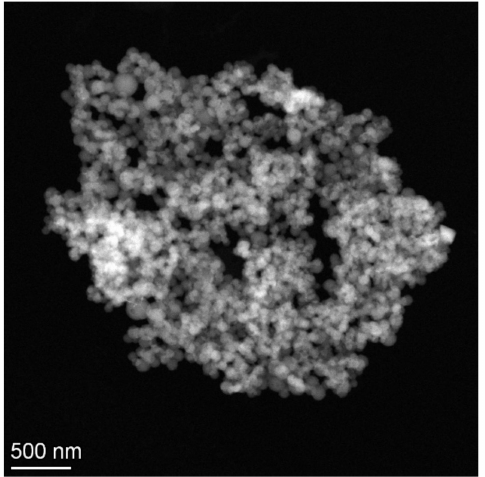
Figure 2. S/TEM images of valsartan-loaded Eudragit ® RLPO nanoparticles.